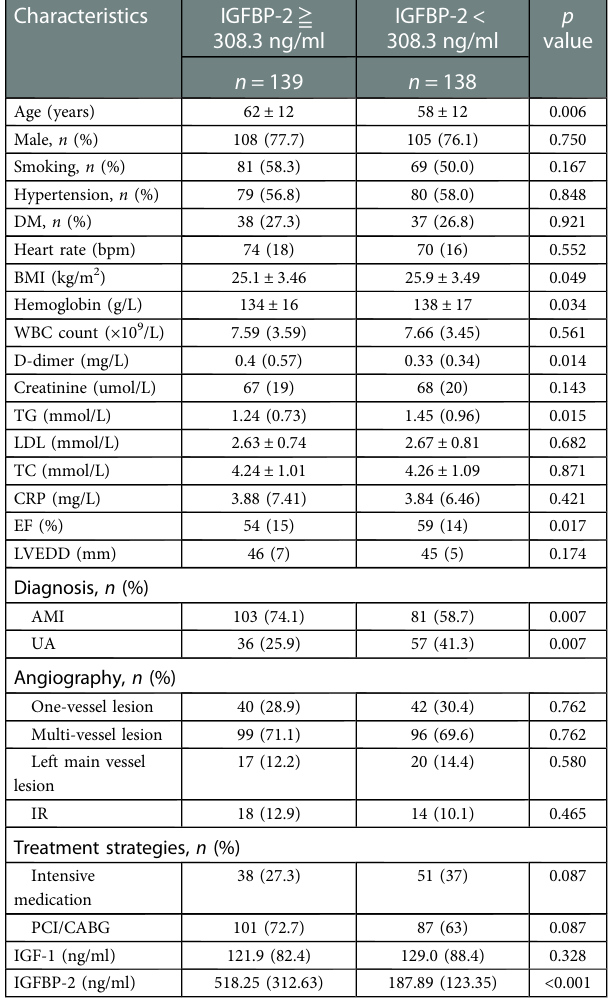
TABLE 3 Basic characteristics of studied patients according to plasma IGFBP-2 levels. Characteristics